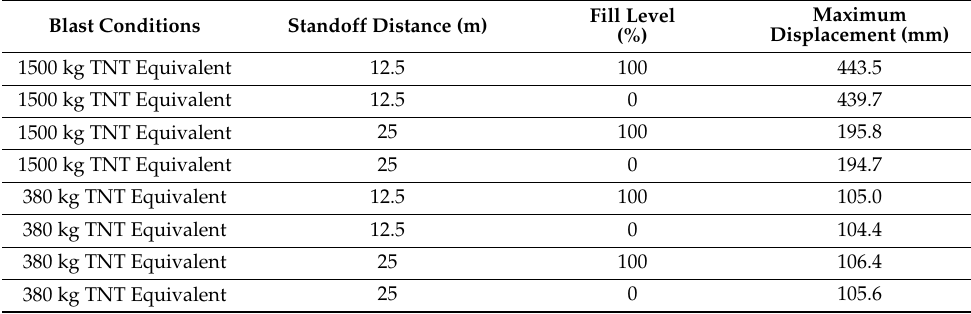
Table 4. Summary of maximum tank displacement at 0.25 s.